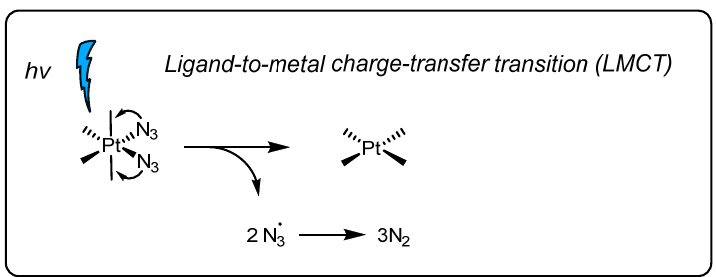
Figure 8. A plausible mechanism for the photoreduction of diazido ‐ Pt(IV) complexes.